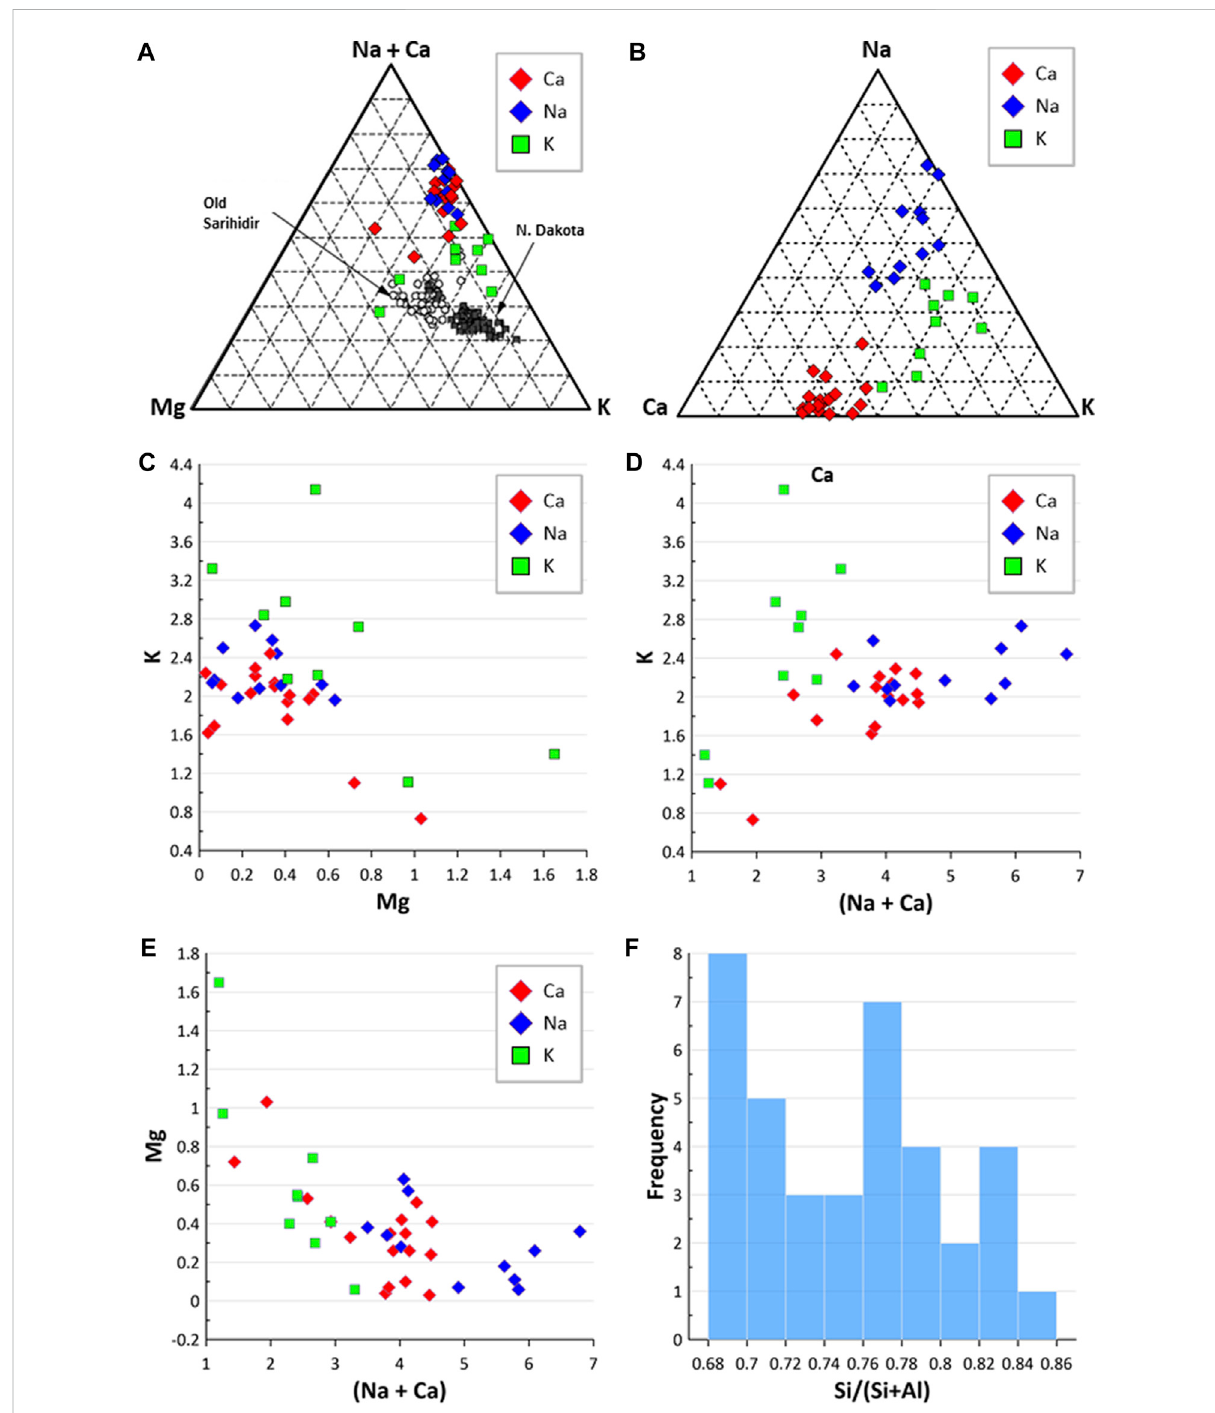
FIGURE 3 Erionitechemistry. (A) TernarydiagramcomparingerioniteglobalgeologicaloccurrencetoerionitefromN.DakotaandOldSarihidir(following Carbone et al., 2011); (B) ternary diagram of Na-C-K; (C) Mg and K composition of different erionite species; (D) comparison of (Na + Ca) values against K; (E) comparison of (Na + Ca) against Mg; (F) frequency of Si/(Si + Al)